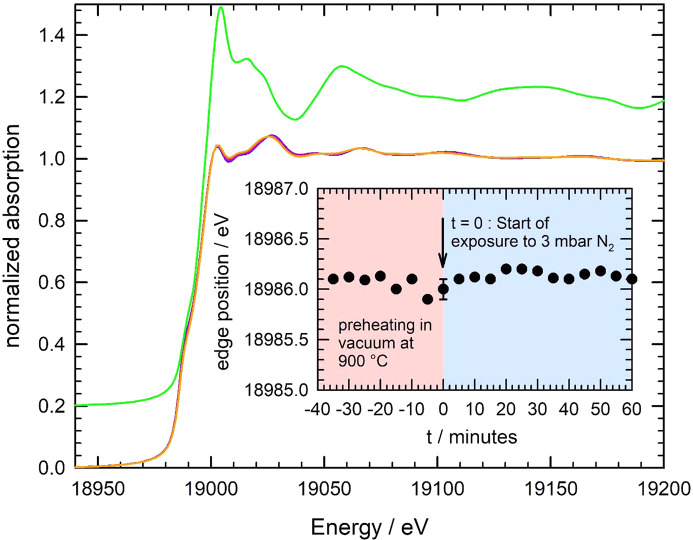

In situ detected XANES spectra at the Nb K-edge measured during the exposure of a stack of two Nb foils (6 µm thickness each) to a nitro­gen atmosphere of 3 mbar at 900°C. The displayed spectra were recorded with 0.5 s per scan (1 Hz), and one spectrum is displayed every five minutes (colour code from dark blue via violet and red to orange with increasing time). The XANES spectrum of the NbN reference material is shown with an offset of +0.2 for a better comparison (green line). In the inset, the determined absorption edge position (defined as the first inflection point of the spectrum) is shown as a function of the exposure time, i.e. t = 0 corresponds to the start of the N2-exposure.